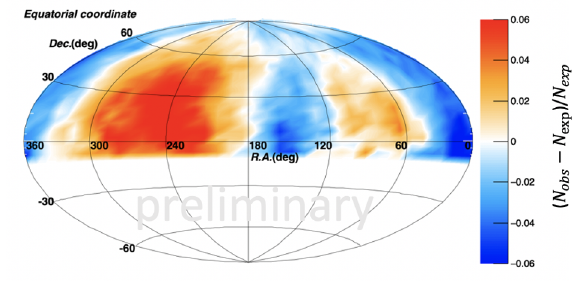
Figure 7. Preliminary residual intensities of 11-years TA SD data below 8EeV in equatorial coordinates